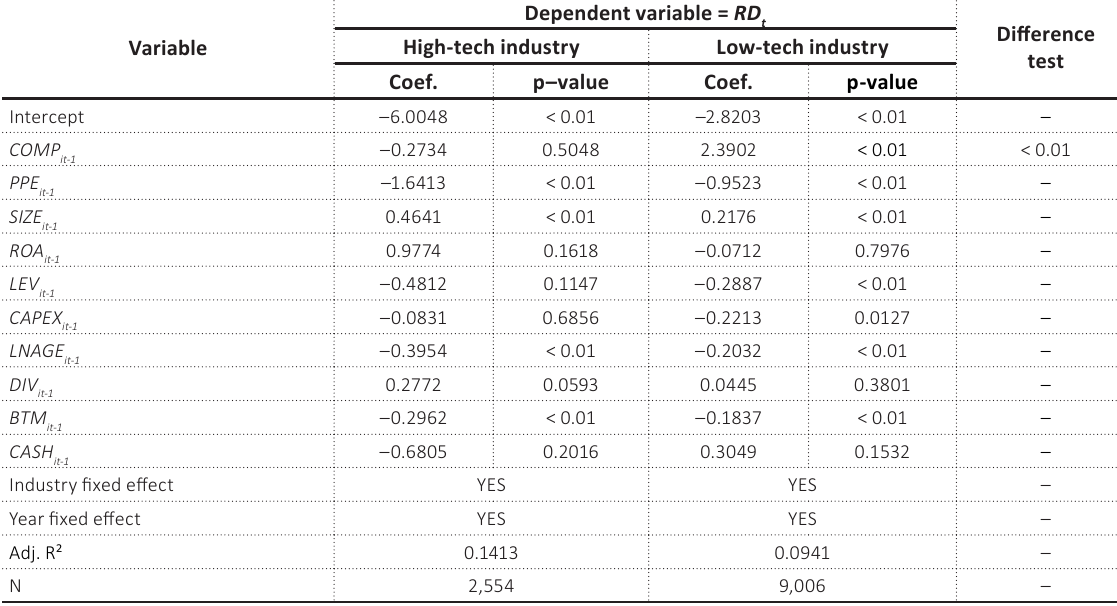
Table 5. The effect of product market competition on a firm’s R&D investments based on the industry